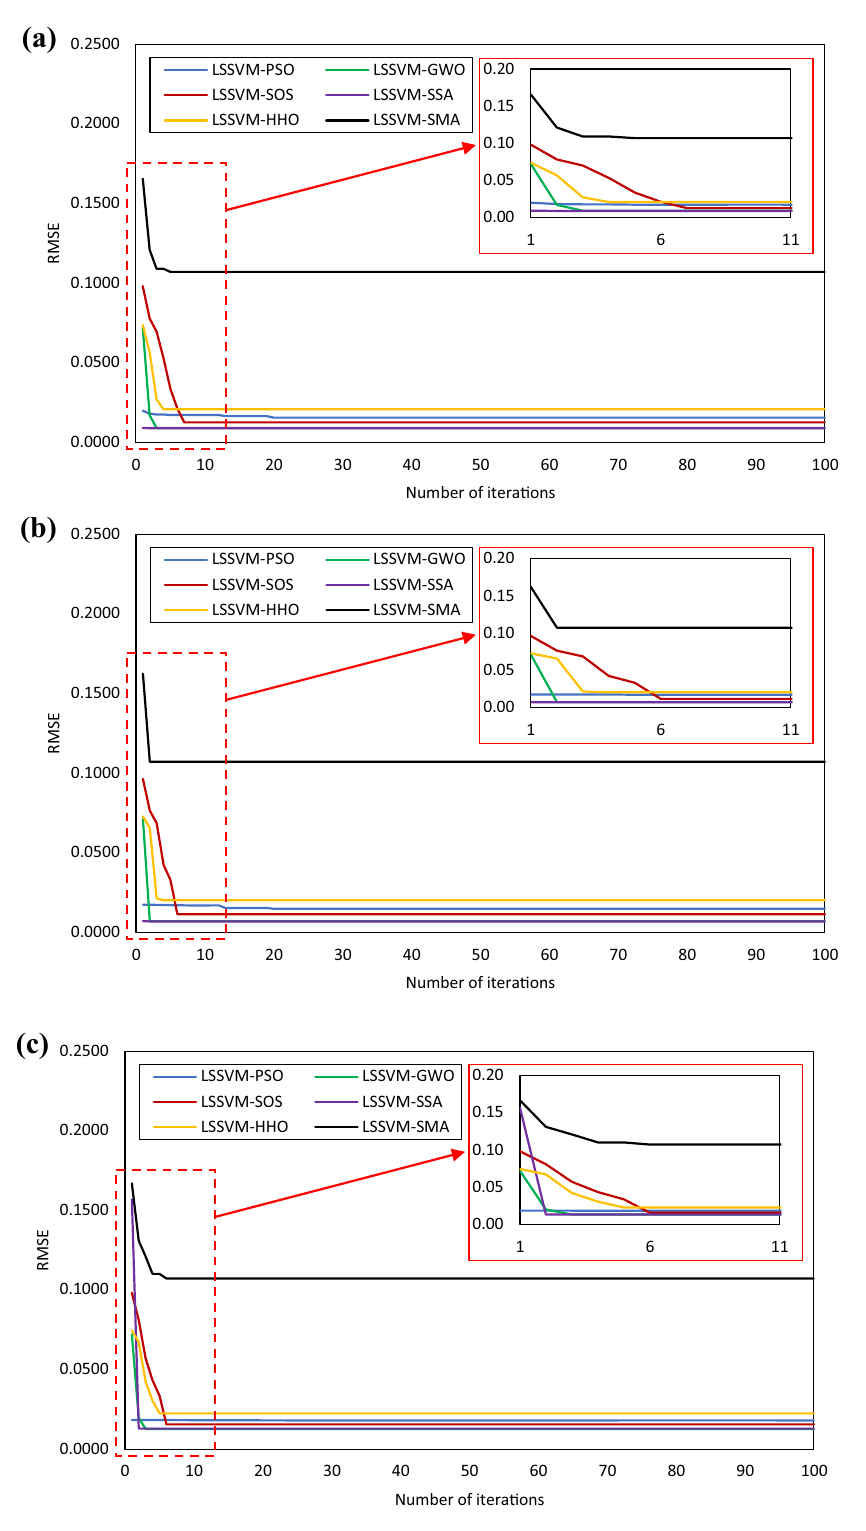
Figure 3. Convergence behaviour of hybrid LSSVMs for ( a ) Set 1, ( b ) Set 2, and ( c ) Set